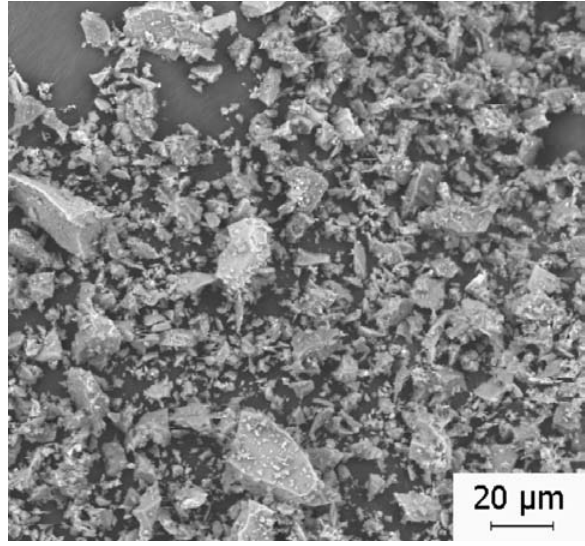
Figure 1. SEM micrograph showing the morphology and impurities, mainly inert ash, in CPII-Z 32 Portland cement powder.